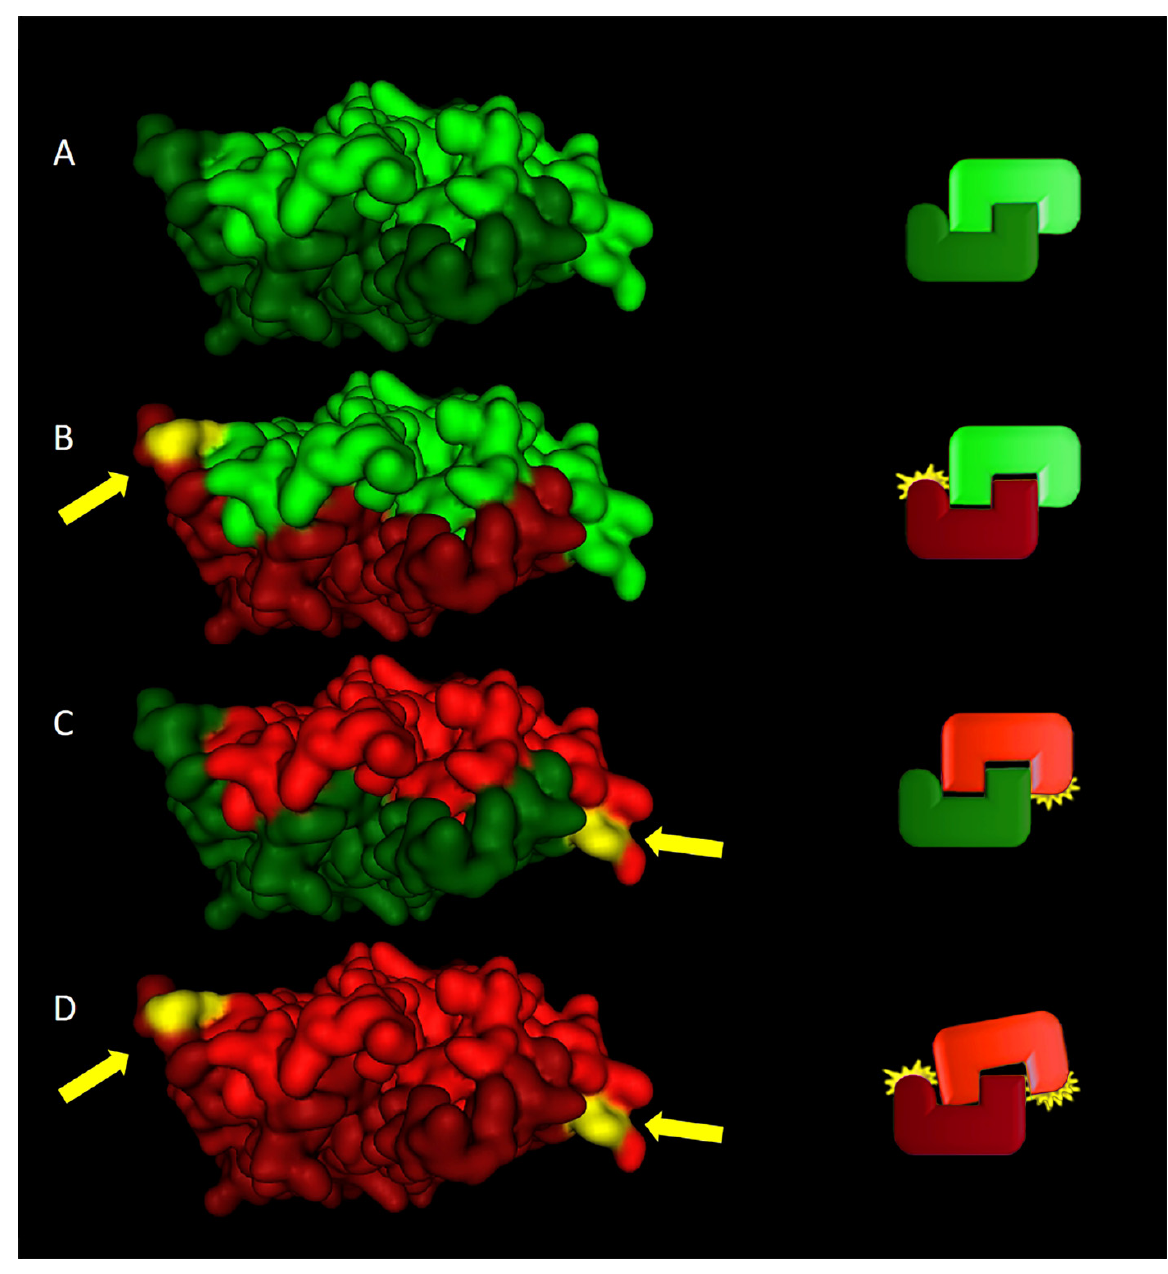
Figure 3. Different assembly scenarios of the LAP2 α R690C dimer in heterozygosity. ( A ) LAP2 α wild-type homodimer assembly. ( B , C ) LAP2 α Arg690Cys heterodimer assembly. ( D ) LAP2 α 690Cys homodimer assembly. The left panel shows the dimer model, and the right panel represents a graphical view of different assembly scenarios showing 690Cys homodimer instability. The wild-type 690Arg chain is depicted in green; the 690Cys chain is depicted in red. Arrows indicate the 690Cys residue.